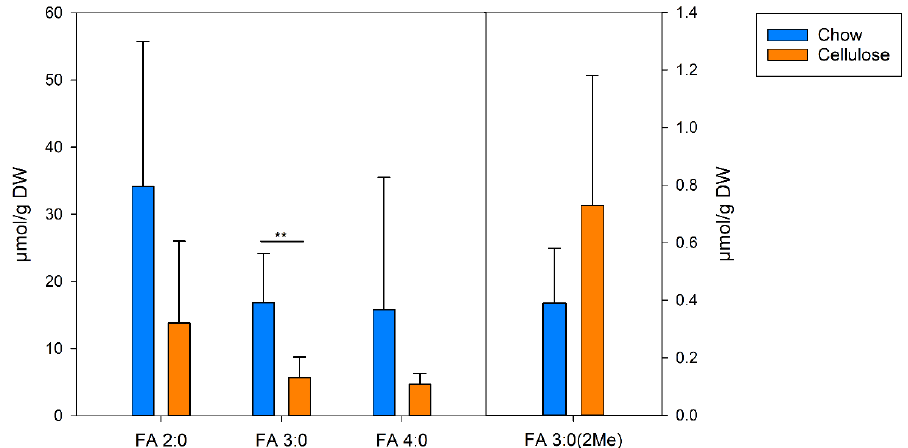
Figure 4. SCFA levels in the colon content of the SPF mice fed a diet containing a non-degradable and -fermentable fiber source. Specific pathogen-free mice were fed for two weeks either a chow diet containing a grain–soybean-based crude fiber extract (5%), or an experimental control diet with 5% purified cellulose instead of crude fiber. The SCFA concentrations were analyzed in the colon content ( n = 6 each group); ** p <